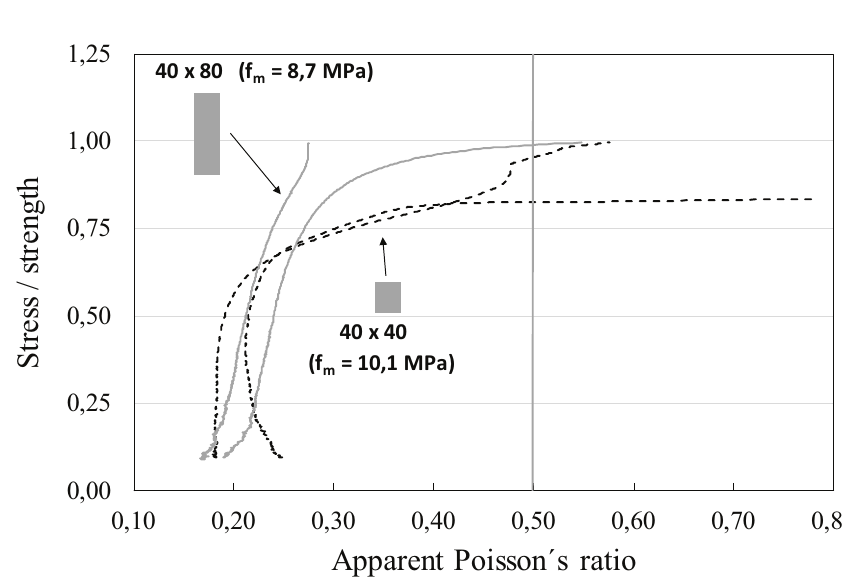
Apparent Poisson´s ratio vs. stress/strength level for the tested mortar